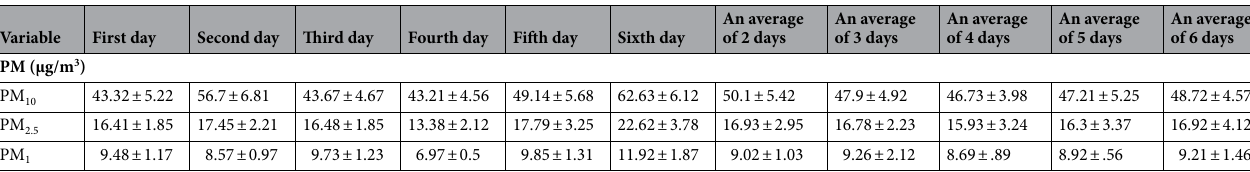
Table 3. The average concentration of exposure to particulate matter measured in a school dormitory in the first sampling period (March-winter).